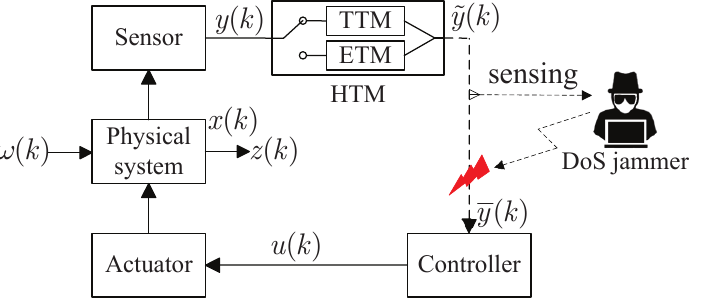
Figure 1. Basic structure of the ICPS with HTM encountering stealthy DoS jamming